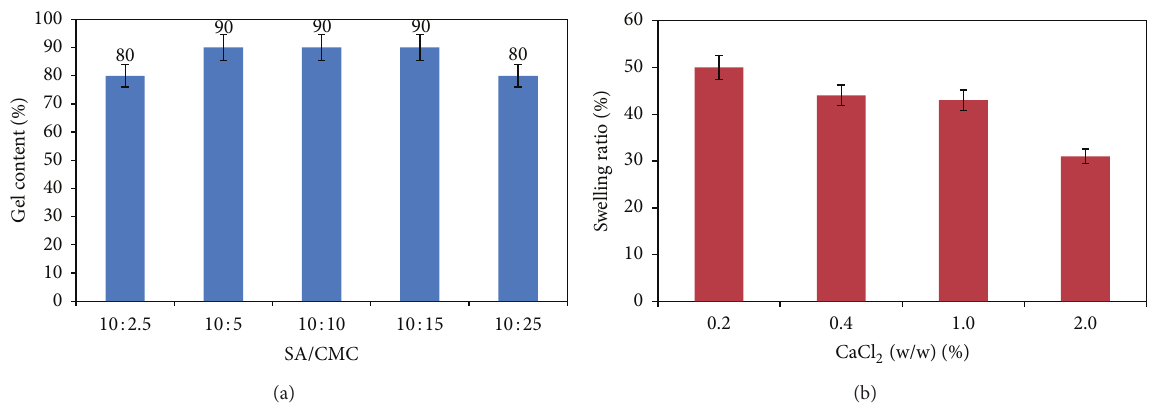
Figure 1: Effect of polymer blend ratio on the (a) gel content and (b) effect of CaCl 2 concentration on the swelling ratio of SA/CMC blends in water.